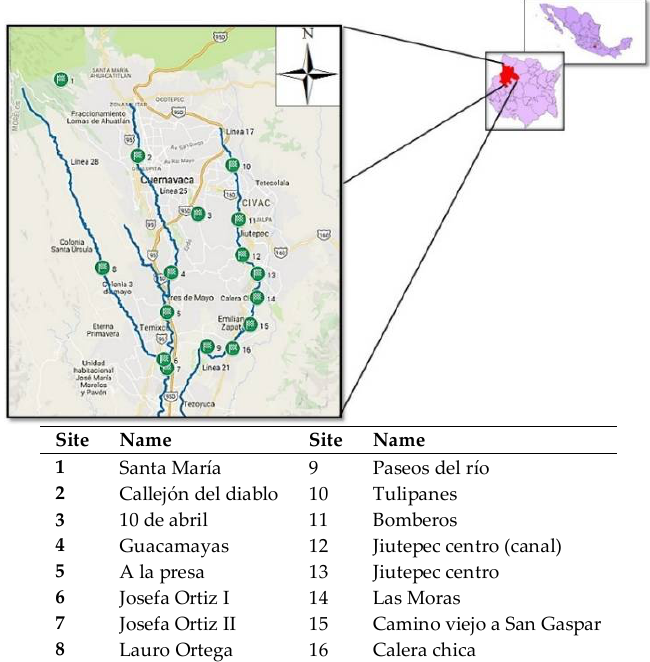
Figure 1. Location of the sampling sites.